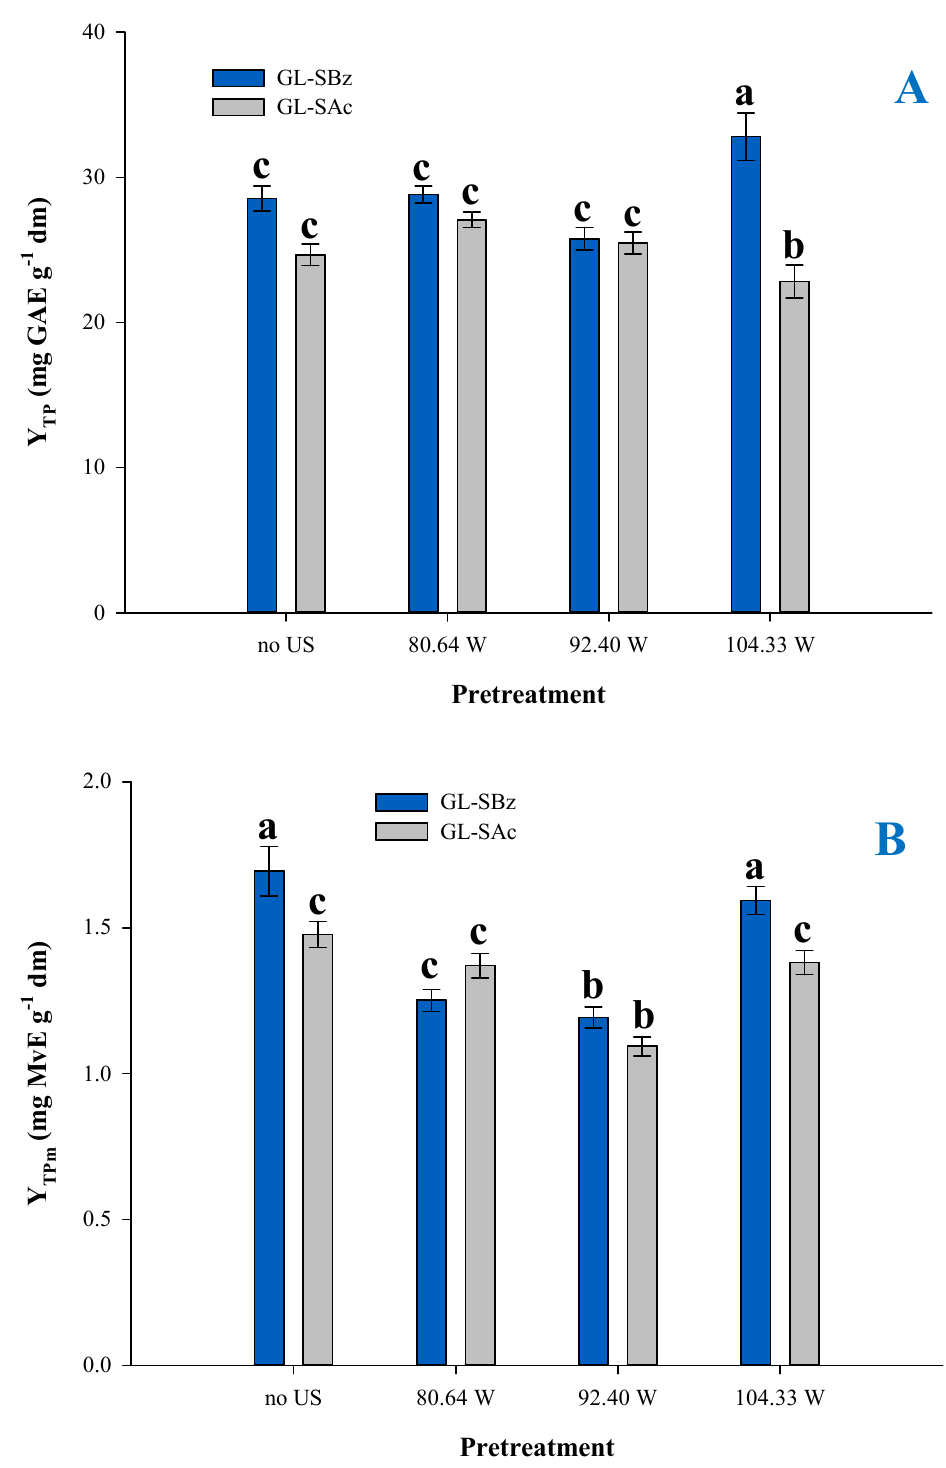
Figure 2. The effect of ultrasonication pretreatment on the yield in total polyphenols (Y TP ) ( A ) and total pigments (Y TPm ) ( B ). Ultrasonication period was 15 min, and it was accomplished at room temperature (25 ± 2 °C). After pretreatment, batch stirred-tank extractions were performed at 50 °C and 500 rpm, with R L/S = 20 mL g − 1 for 150 min. Letters a, b and c signify statistical difference ( p < 0.05).